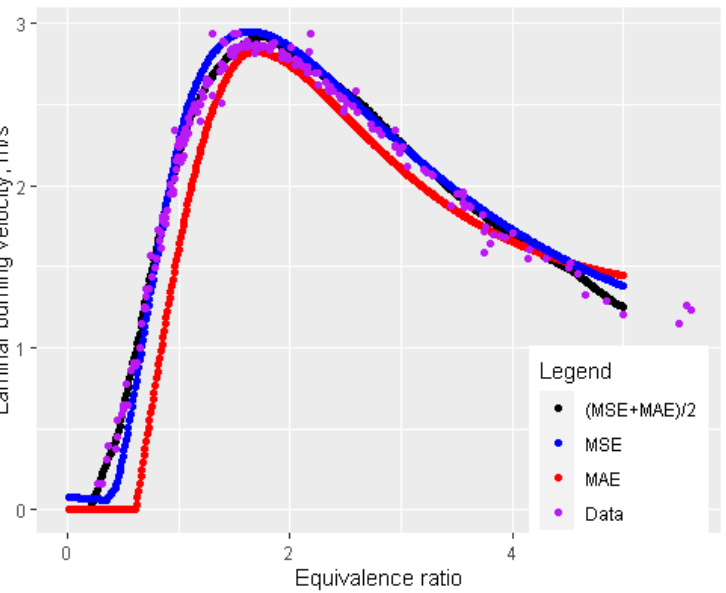
Figure 3. Predicted loss function behavior tested by comparing DNN models with different loss